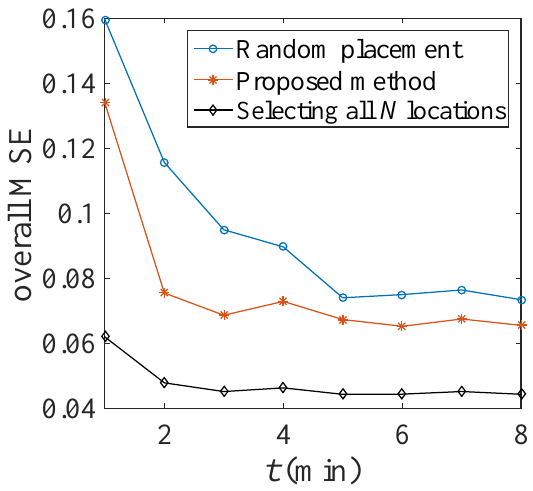
Figure 8. Comparison of the performance metric for the proposed method, random placement and the best case (only 15 sensors are selected on every t